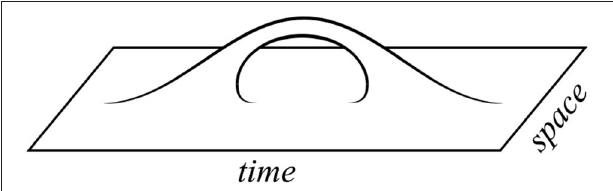
FIGURE 1 | Wormhole corresponding to the creation and absorption of a baby